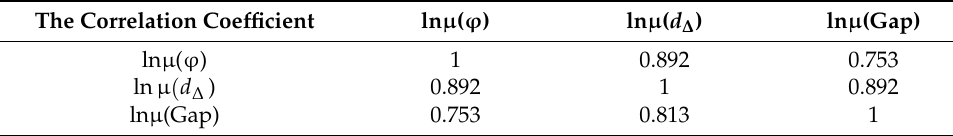
Table 4. Correlation coefficients of structure seismic